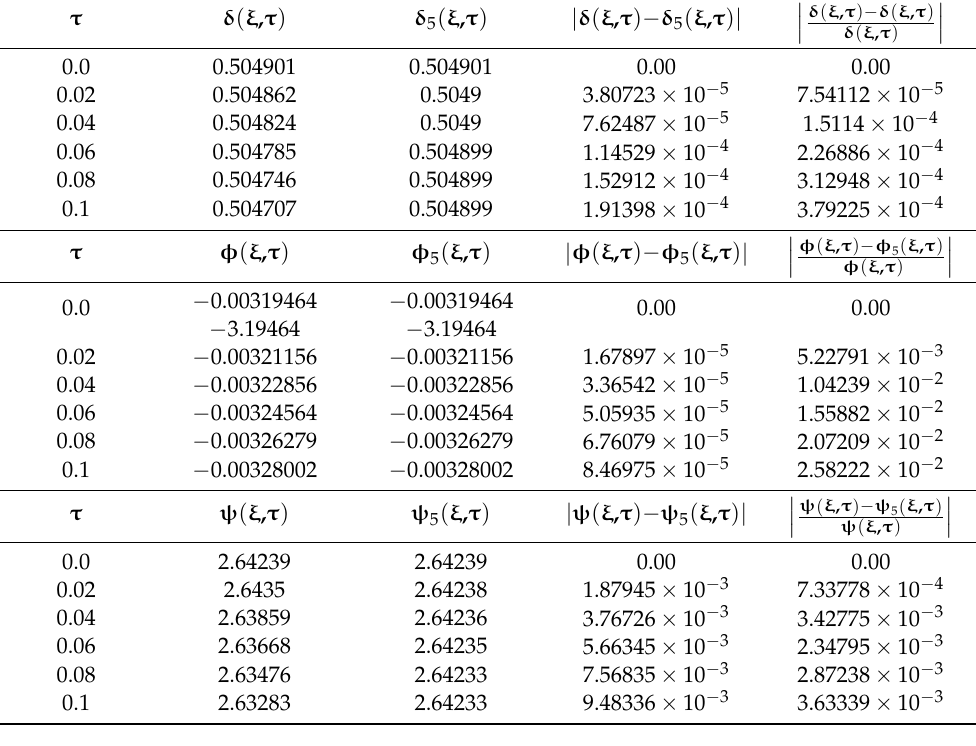
Table 1. The values of and and the values of the 6th approximate of the LRPSM solution for HSC–KdV equations α = 1 at and ξ = 0.1.